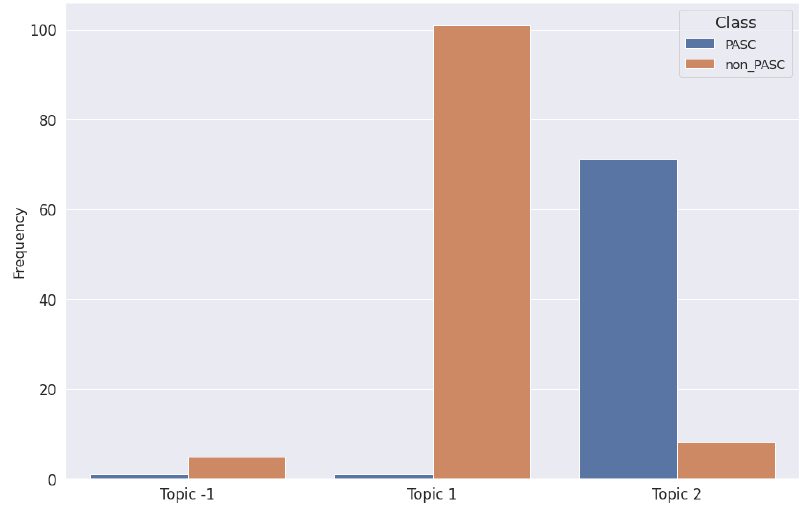
Figure 7. Bar chart describing the distribution of topics modeled trough the BERTopic approach wrt PASC or non-PASC